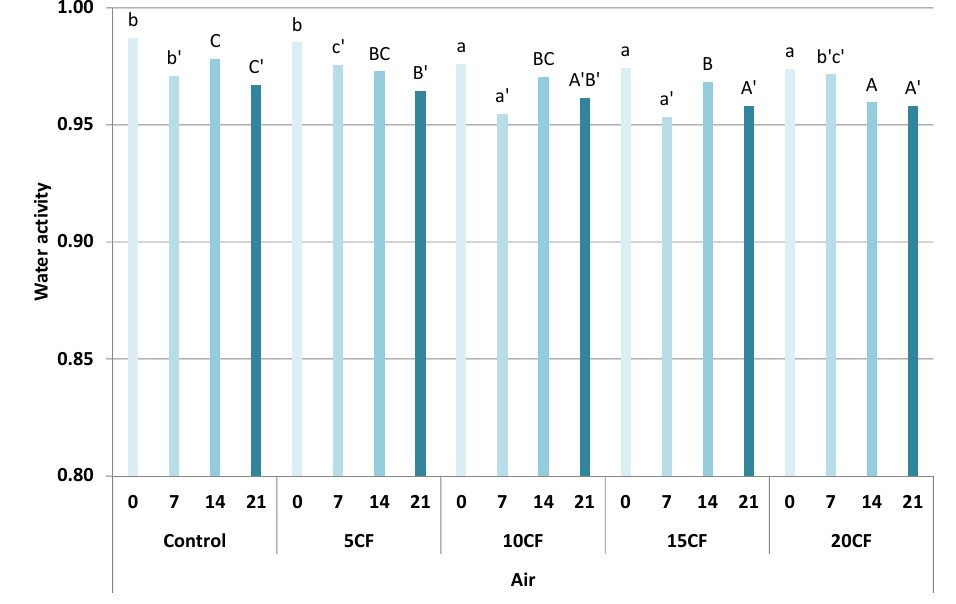
Figure 3. Water activity of gluten-free breads with the addition of chestnut flour in the amount of 5% (5CF), 10% (10CF), 15% (15CF) and 20% (20CF) after 7, 14 and 21 days of storage, packed in a barrier film with air. Values marked with the same symbols mean no statistically significant differences (α = 0.05).